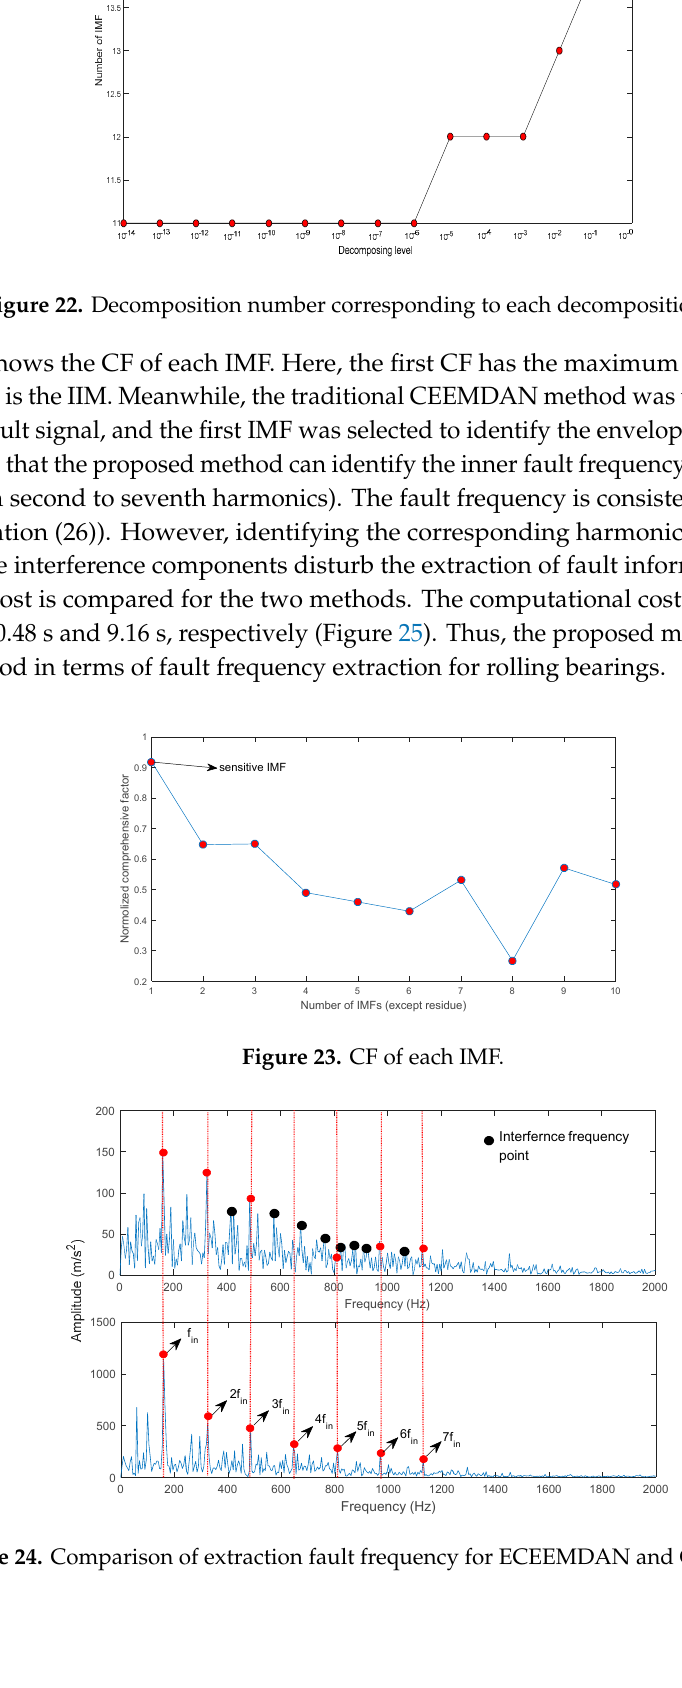
Figure 21. Decomposition result for a vibration signal with an inner raceway fault.